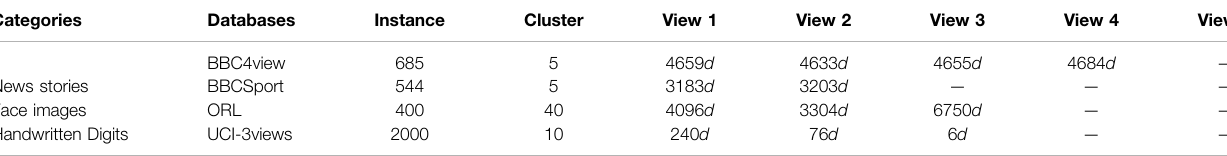
TABLE 1 | Information of four real multi-view databases.